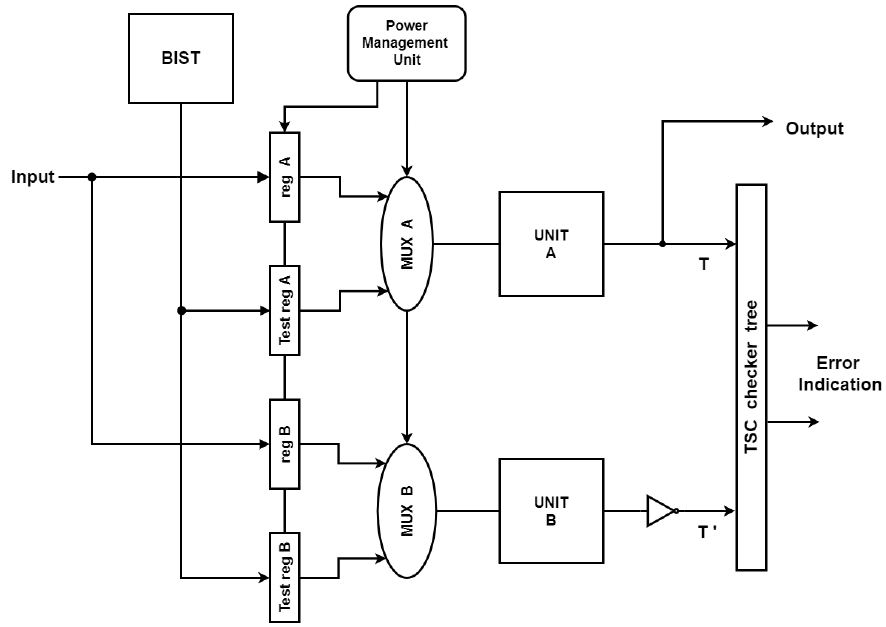
Figure 6. The proposed architecture with the use of the BIST